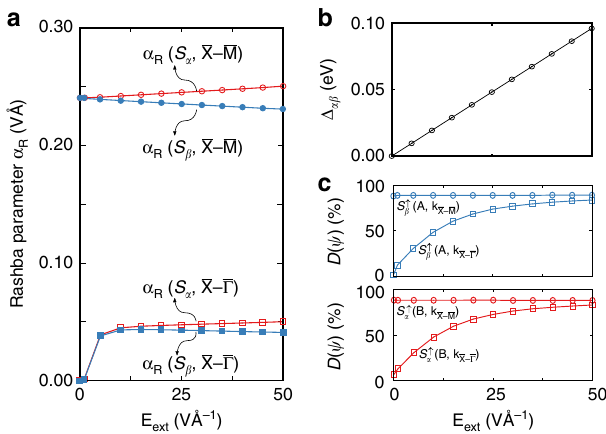
Fig. 3 The evolution of Rashba physics under electric fi eld in monolayer BaNiS 2 . a The Rashba parameters of the spin-splitting bands segregated on the sector S α (red empty squares or circles) and sector S β (blue solid squares or circles), respectively, along (cid:1) X (cid:1) (cid:1) Γ (square) and (cid:1) X (cid:1) (cid:1) M (circle) directions as a function of applied electric fi eld. b Electric fi eld induced energy separation ( Δ αβ ) between the S α -Rashba band and the S β -Rashba band at X point. c Degree of wavefunction segregation of branch A (upper panel) and branch B (lower panel) along (cid:1) X (cid:1) (cid:1) Γ and (cid:1) X (cid:1) (cid:1) M directions, respectively, as functions of the applied electric fi eld. It is noteworthy that the Rashba parameter shown in a is a sum of dipole fi elds weighted by corresponding wavefunction amplitudes and are not necessary to display a simple linear correlation with the DWS (shown in c ), a degree of wavefunction segregation de fi ned in Eqs. (1) and (cid:3) # ð ; k (cid:1) ¼ Fig. 2b shows DWS is D S α = β A X (cid:1) (cid:1) Γ 2 % for spin-down components of both A and B branches.